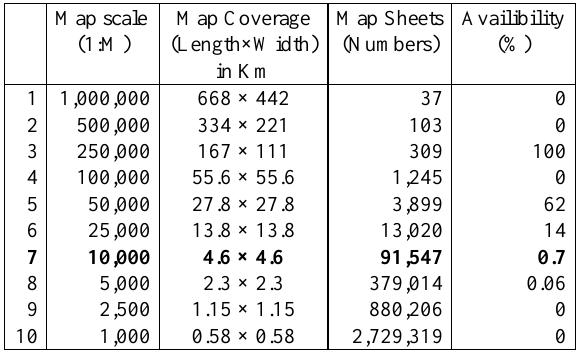
Table 1. Indonesian Topographical Maps